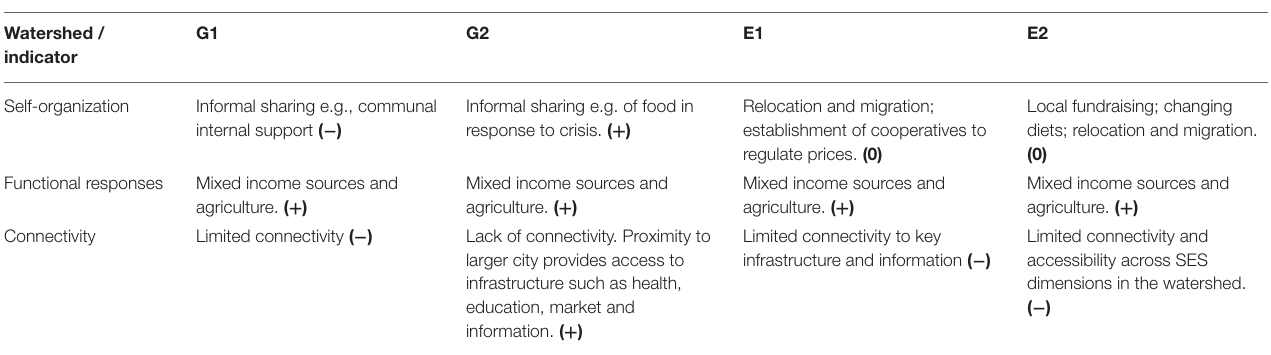
TABLE 7 | Indicator scoring results on contextual systemic factors for the four watersheds G1, G2, E1 and E2. Watershed /